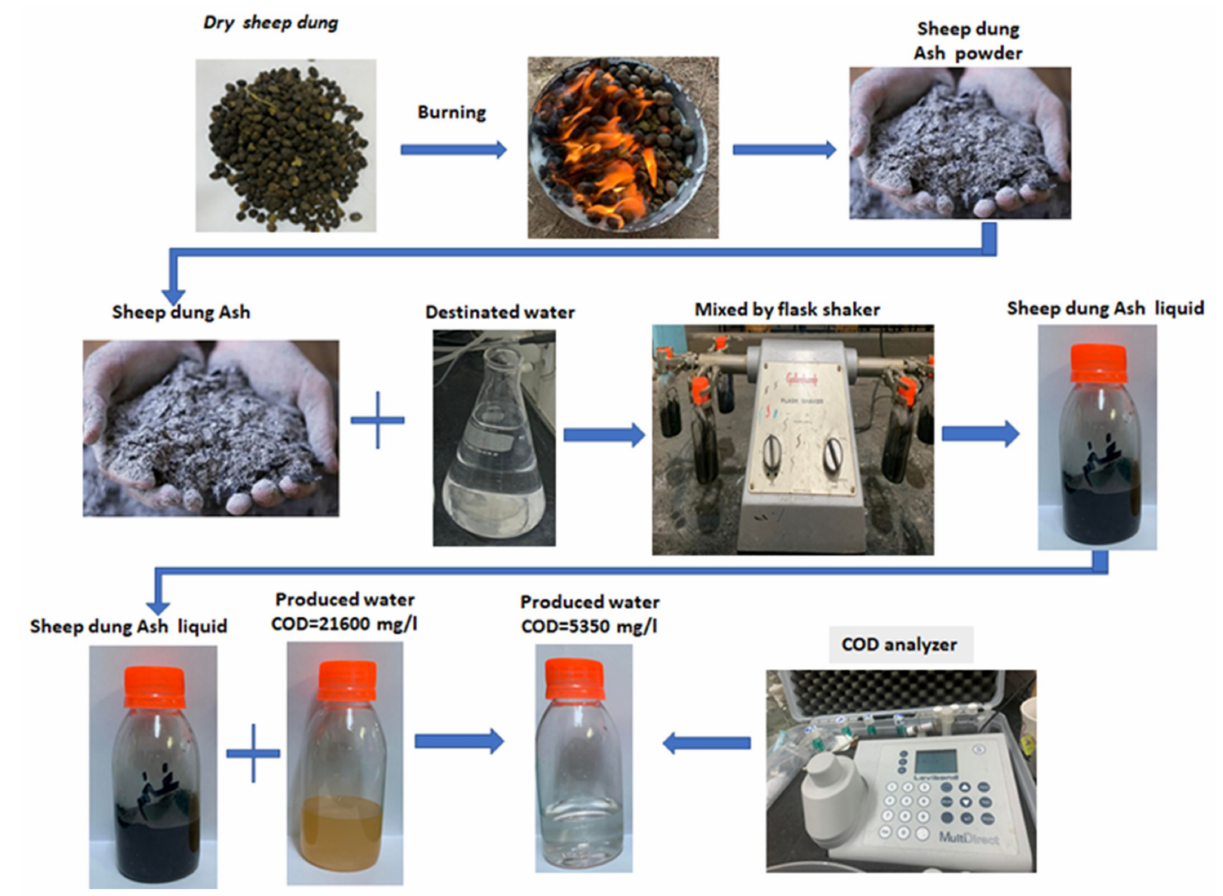
Figure 1. Schematic diagram of the experimental procedure in this